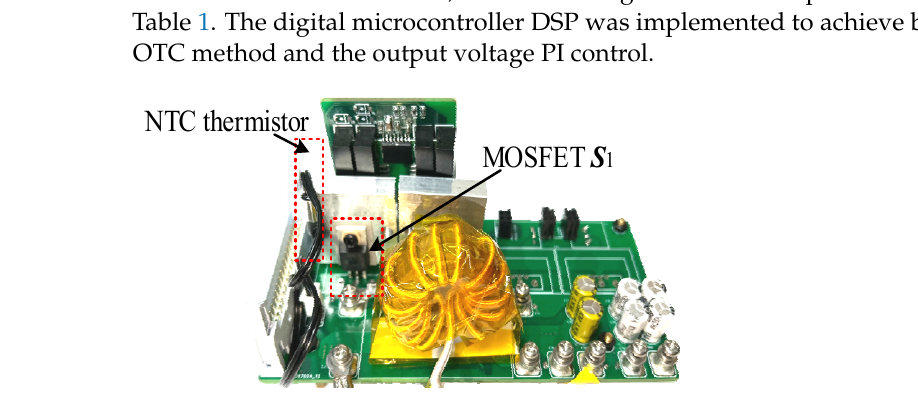
Figure 12. Experimental prototype of a bidirectional boost converter.